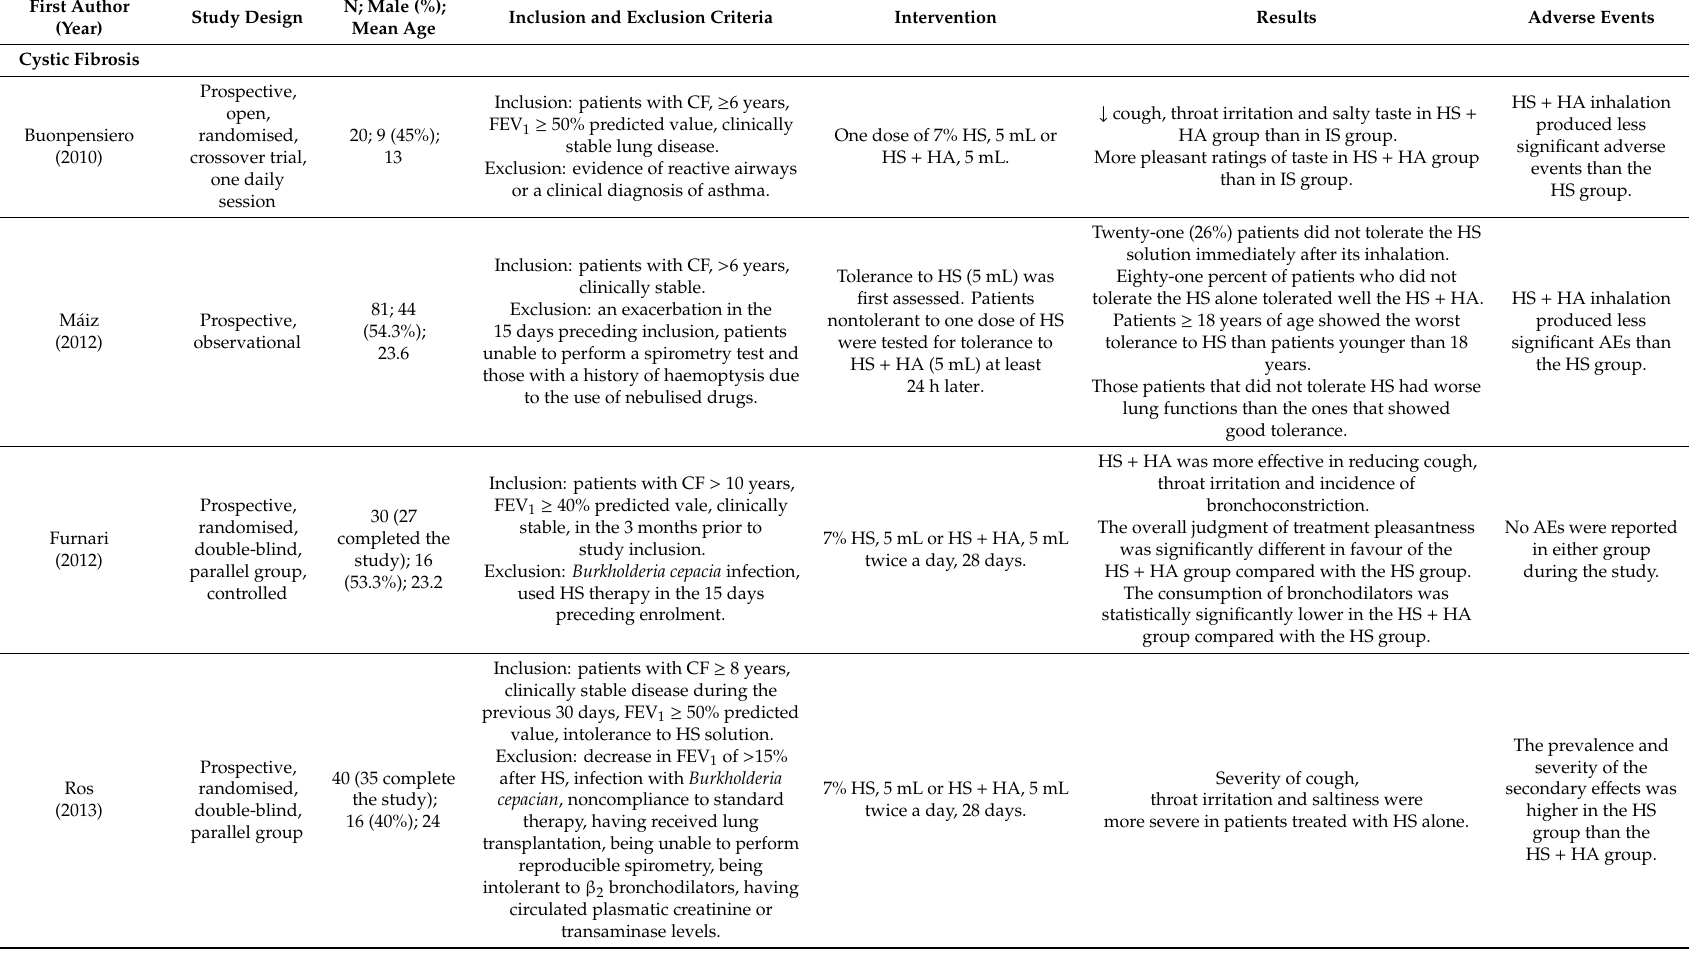
Table 3. Clinical studies of use of hyaluronic acid plus hypertonic solution in cystic fibrosis and